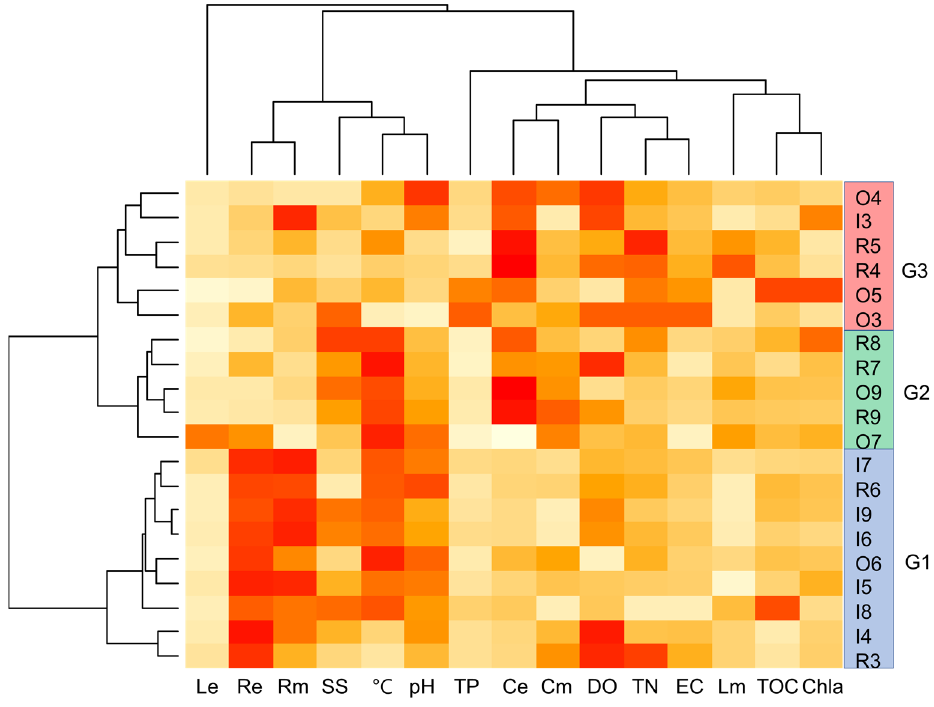
Figure 3. Hierarchical clustering of 20 sampling sites according to the zooplankton communities and environmental variables and cluster distance according to the Bray–Curtis dissimilarity. The vertical axis indicates the sampling site (I: inflow stream, R: reservoir, O: outflow stream), and the numbers mean the sampling month. The horizontal axis indicates the environmental variables and zooplankton communities. Ce and Cm are the relative frequencies of Copepoda, which are measured with MSI and eDNA metabarcoding, respectively. Le and Lm are the relative frequencies of Cladocera and Re and Rm are the relative frequencies of Rotifera.